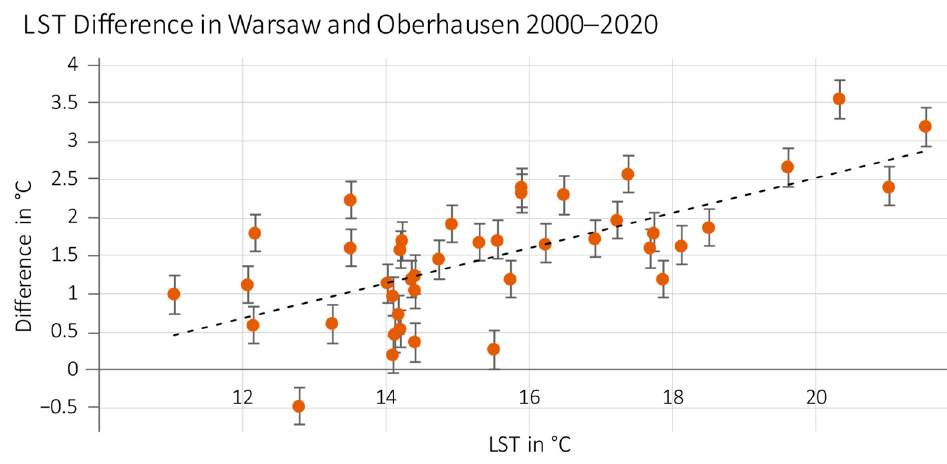
Figure 6. LST difference in Oberhausen and Warsaw 2000–2020.